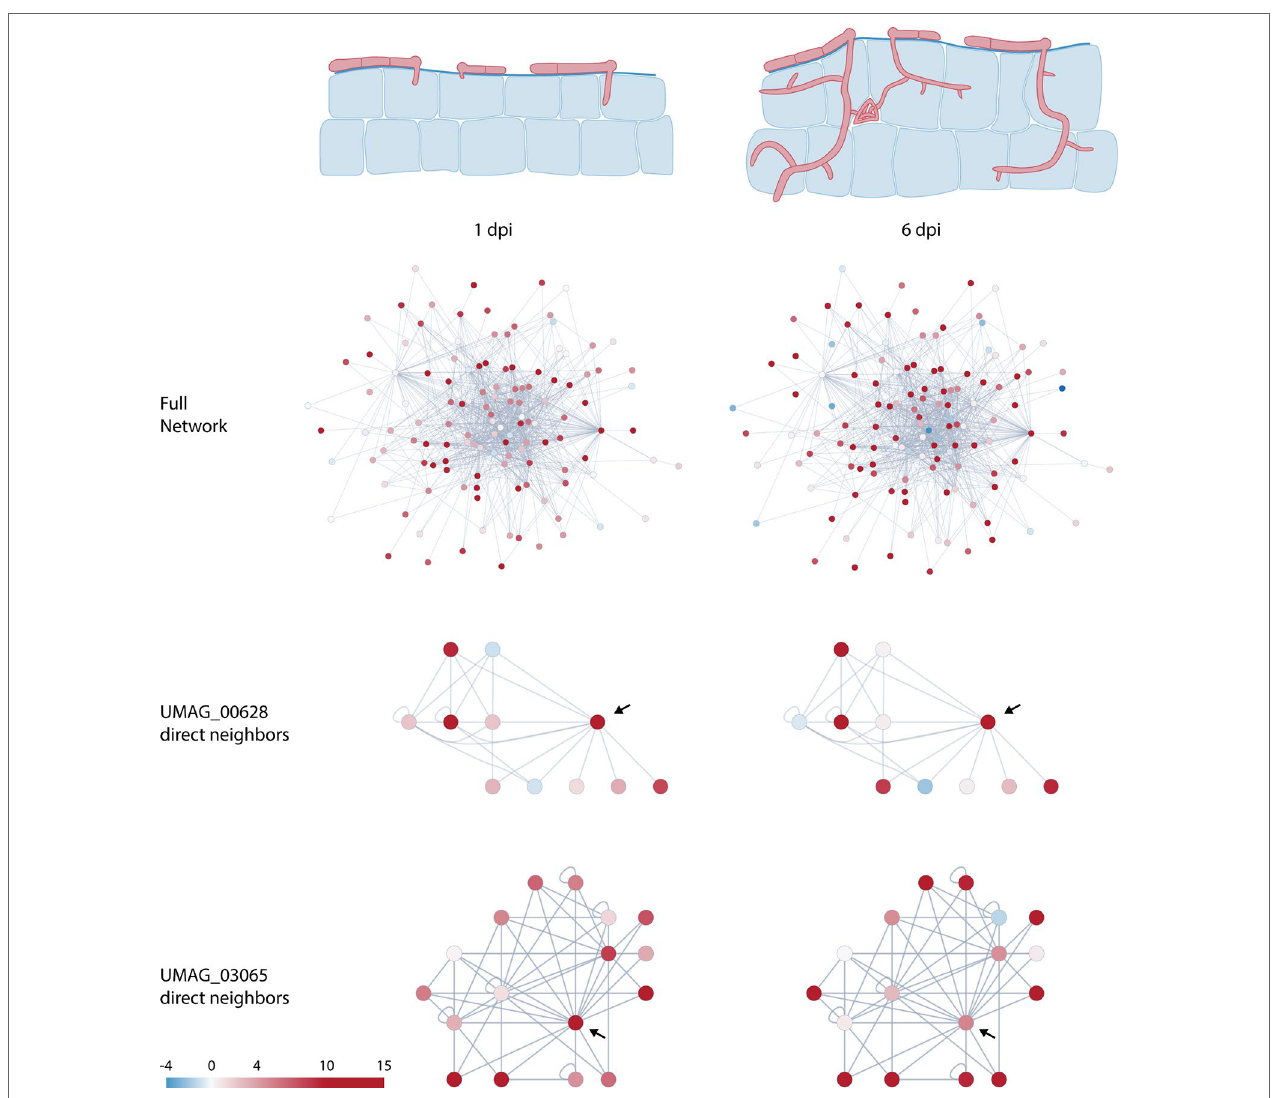
FigURE 2 | Schematic representation of U. maydis infection at 1 and 6 days post infection (dpi) and changes in predicted protein–protein interaction network dynamics of putative effectors. Nodes are colored according to Log 2 fold change relative to axenic culture (Lanver et al., 2018). Arrows in the subnetworks indicate network